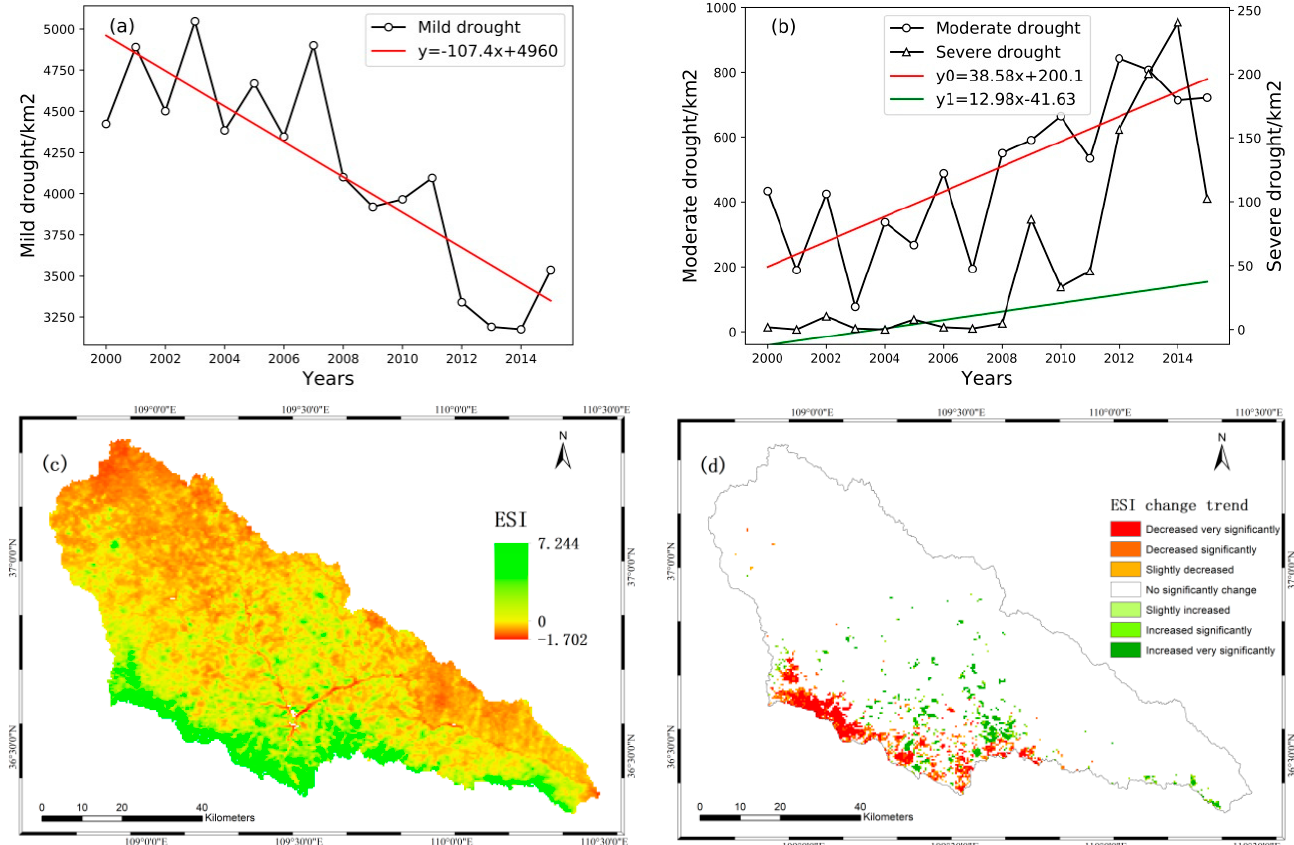
Figure 6. ESI in the YanHe Watershed from 2000–2015: ( a ) Time series of mild drought area; ( b ) time series of moderate and severe drought areas; ( c ) spatial variation of annual average ESI value; ( d ) change trend map of ESI (significance level 95%).